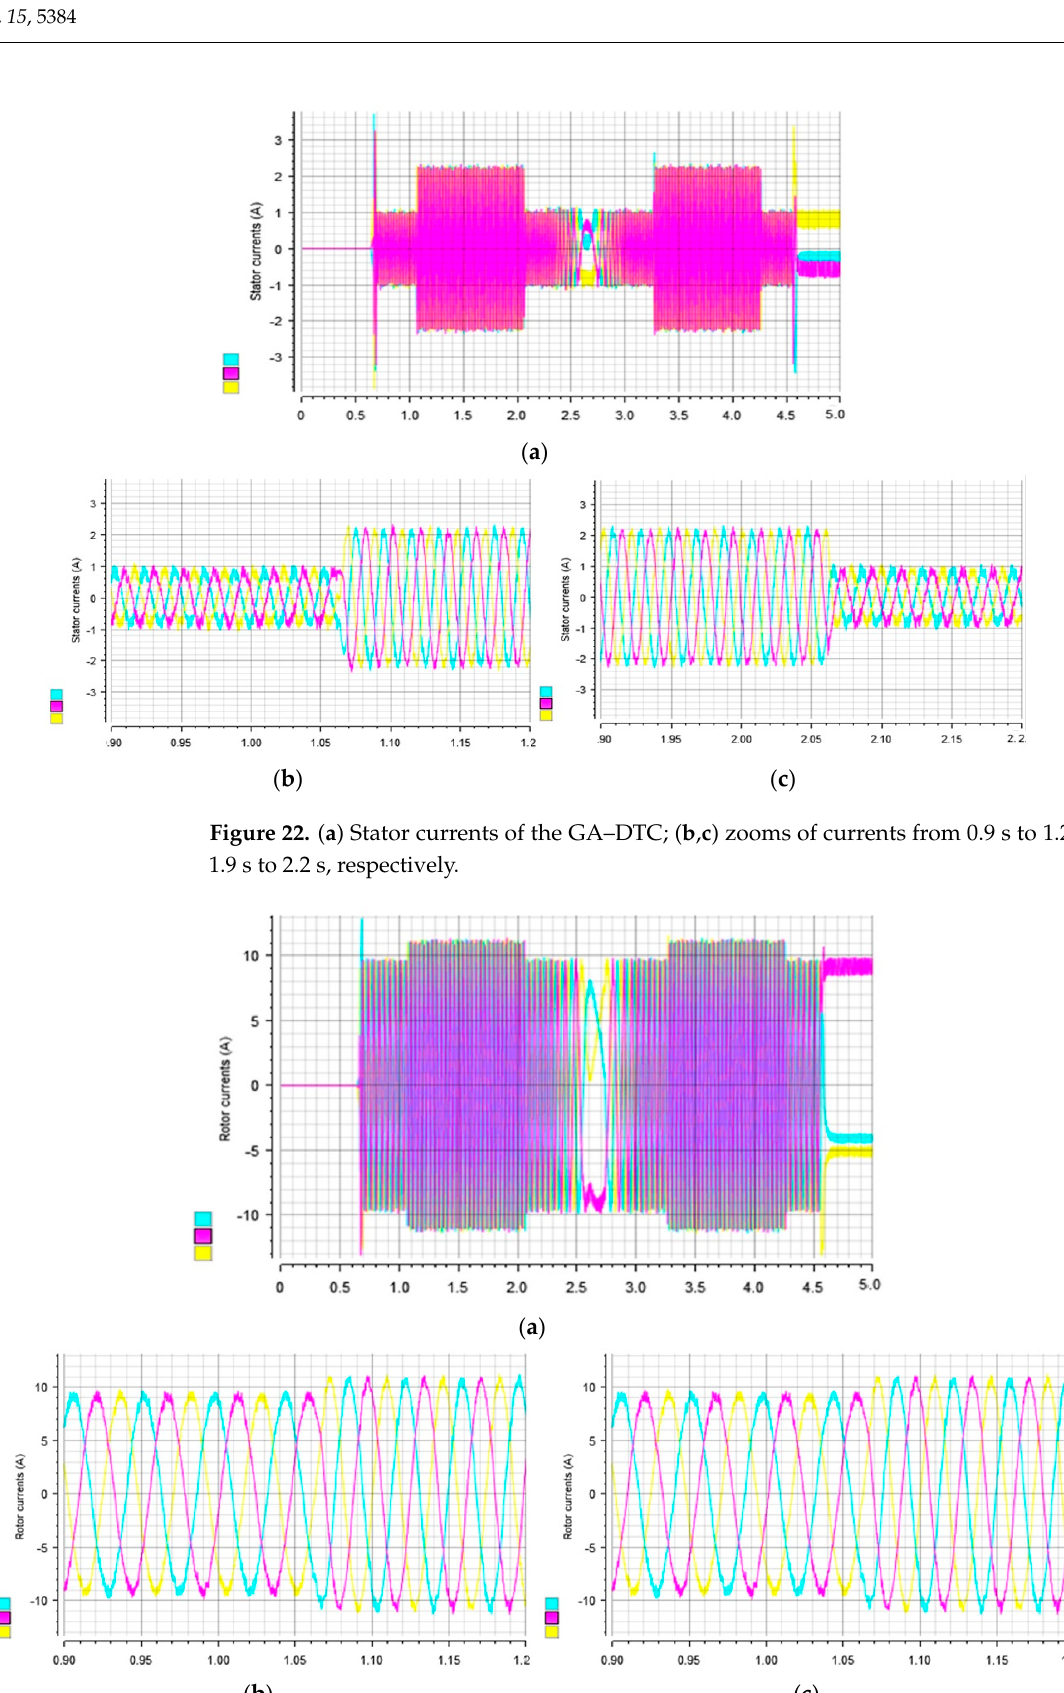
Figure 23. Stator currents of the GA–DTC; ( a , b ) zooms of currents from 0.9 s to 1.2 s and from 1.9 s to 2.2 s, respectively.